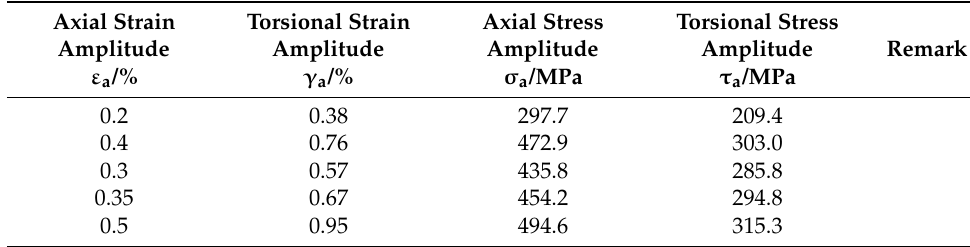
Table A9. Test results for nonproportional combination of axial and torsional load ( γ a / ε a = 1.9), phase shift between torsion and bending ∆ ϕ = 90 ◦